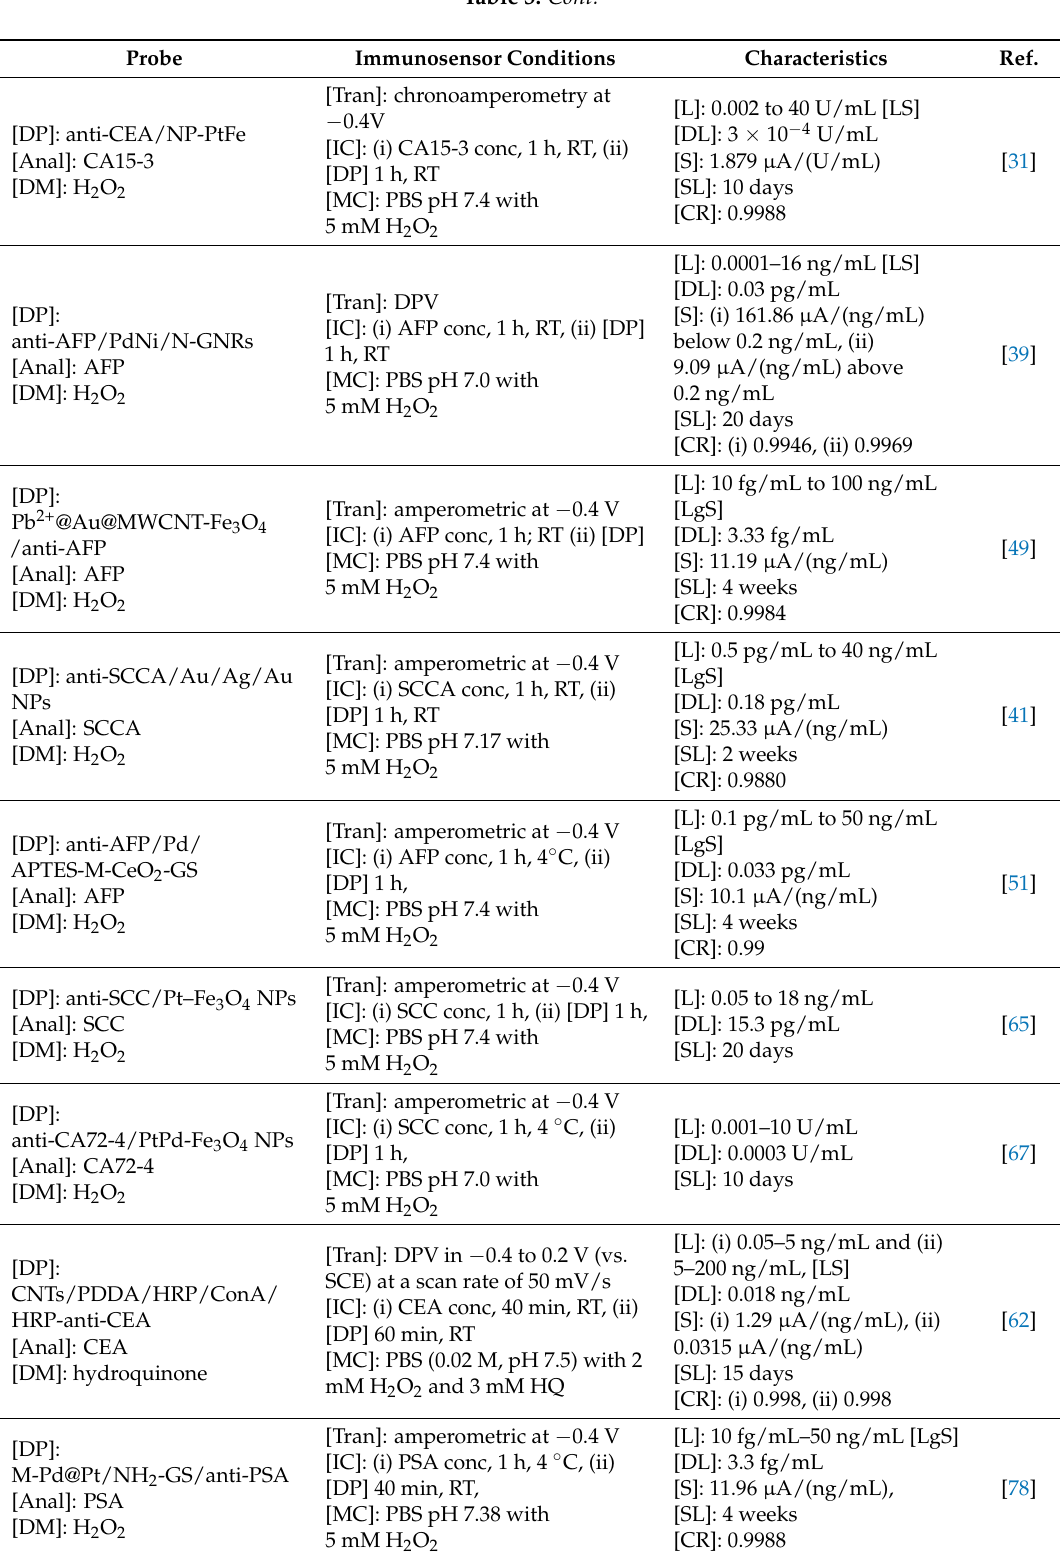
Probe Immunosensor Conditions Characteristics